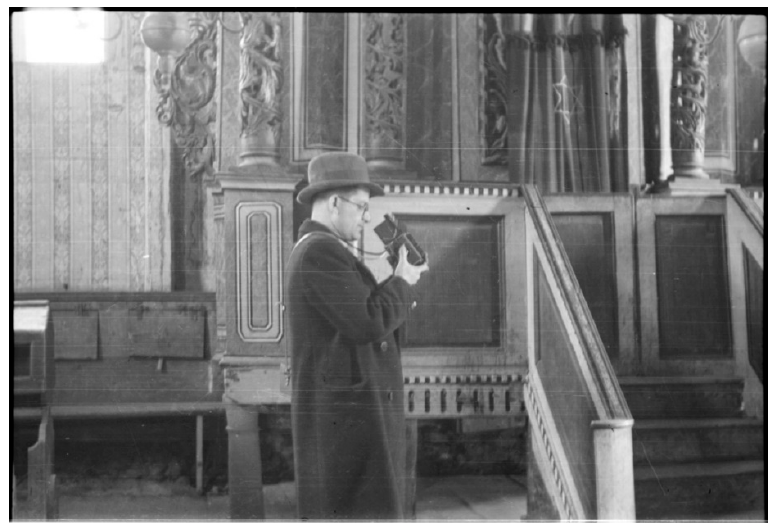
Figure 3. Chackelis Lemchen explores the Pakruojis synagogue, 1938. Šiauliai Aušra Museum. Photo Stasys Vaitkus, used with permission.